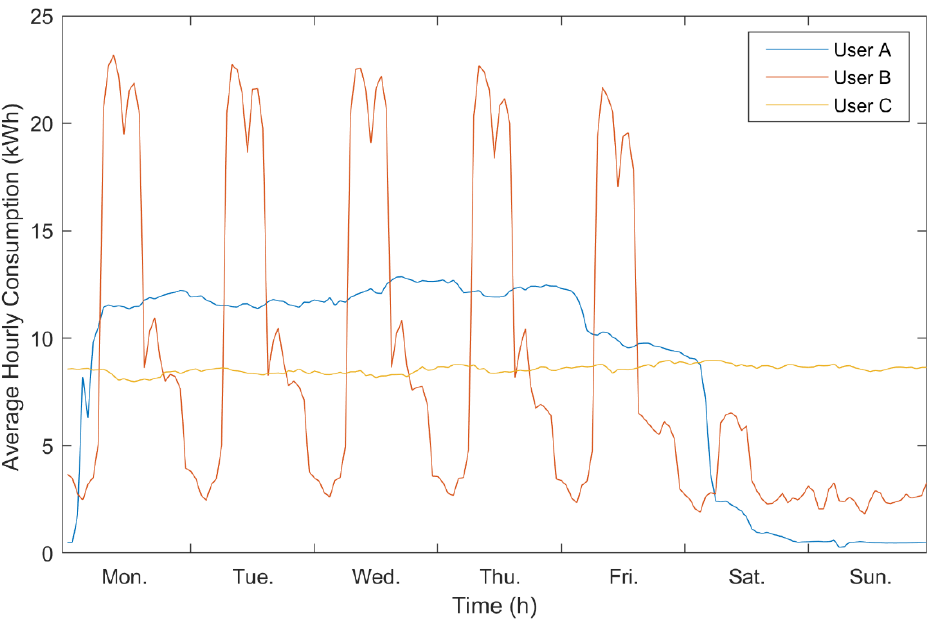
Figure 4. Weekly load hourly profile of the users included in the study. Table 4. Price of energy for each 3.0 TD tariff